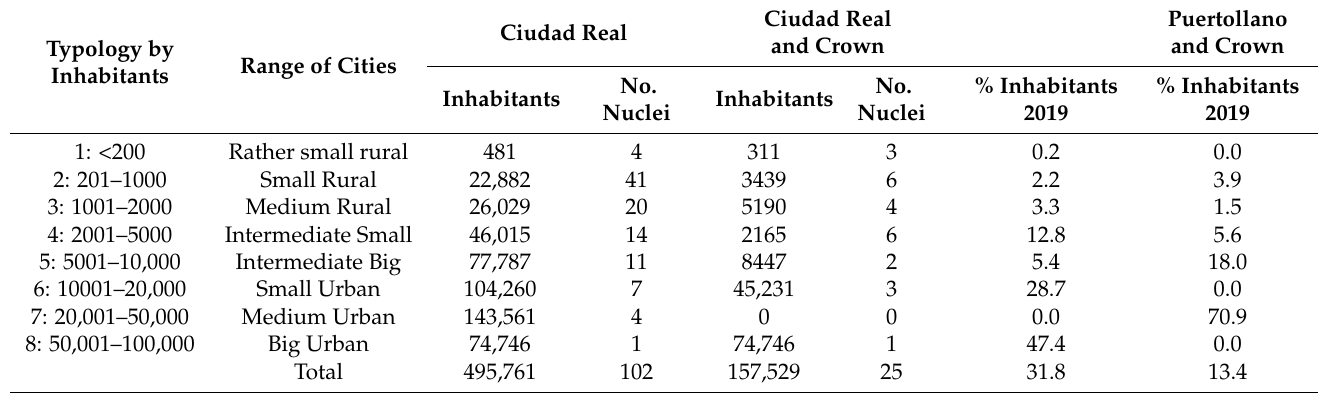
Table 1. Typology by inhabitants of the province through their medium-sized cities. Source: Compi- lation based on ID2CR project: Depopulation and depopulation in Ciudad Real .